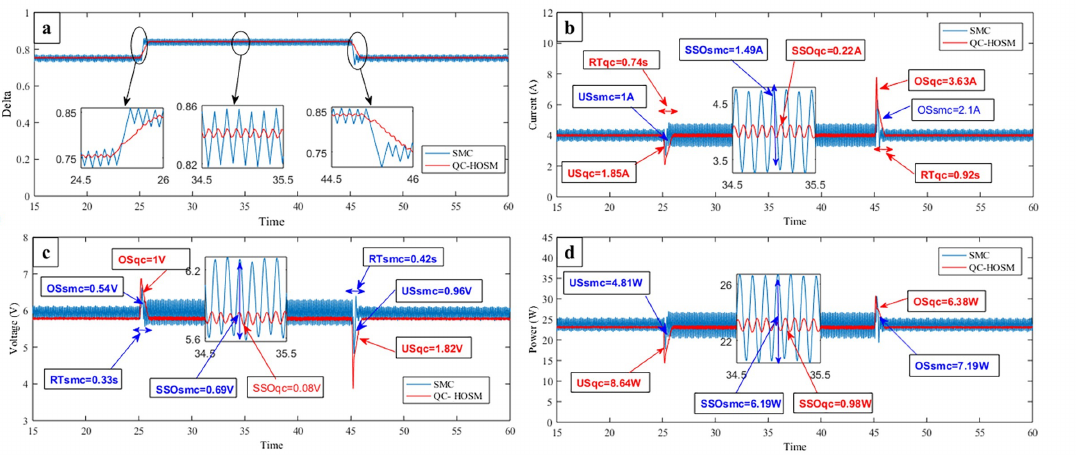
Figure 8. Proton exchange membrane fuel cell (PEMFC) different signals; ( a ) duty cycle; ( b ) stack current; ( c ) stack voltage; ( d ) stack